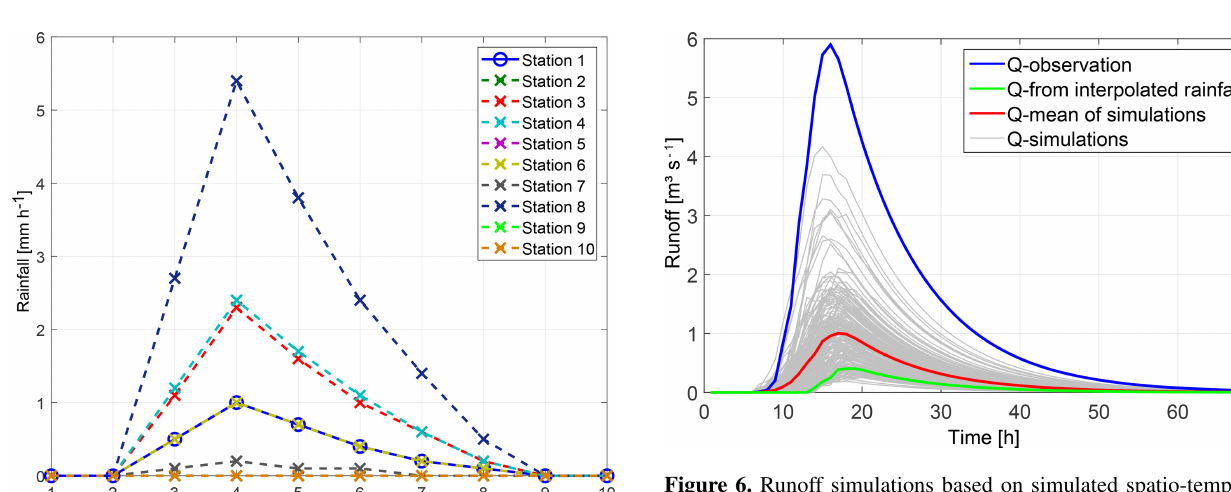
Figure 6. Runoff simulations based on simulated spatio-temporal rainfall patterns conditioned at rainfall point observations only (grey graphs) compared to its mean (red graph), runoff observation (blue graph), and simulation based on interpolated rainfall patterns (green